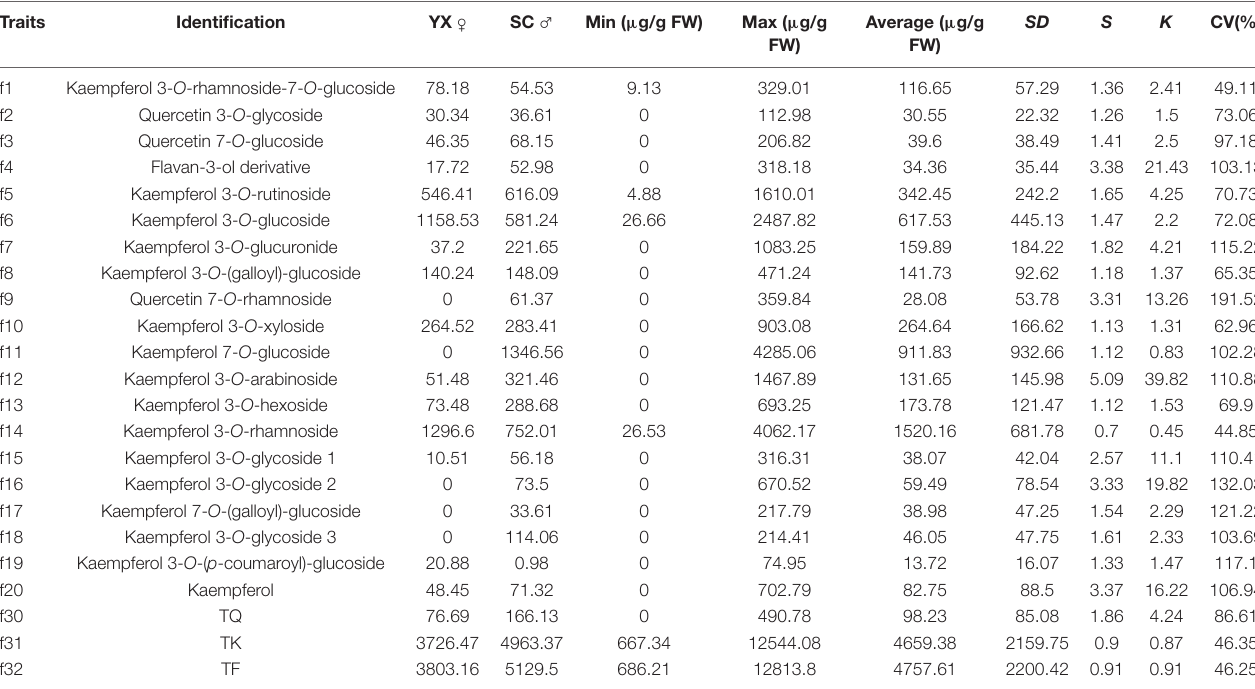
FIGURE 1 | Frequency distribution of anthocyanin contents in the tetraploid rose YS population. Cy3G5G, cyanidin 3,5-diglucoside; Pg3G5G, pelargonidin 3,5-diglucoside; Cy3G, cyanidin 3- O -glucoside; Pg3G, pelargonidin 3- O -glucoside. TABLE 2 | Statistical analysis of flavonols in the petals of parents and